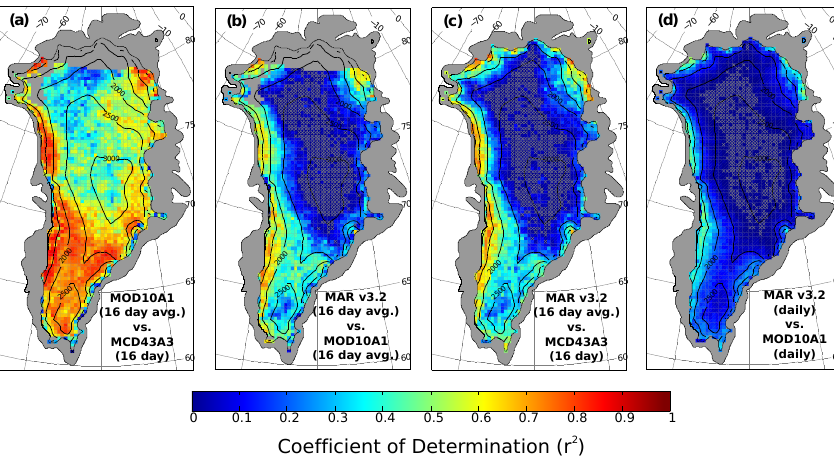
Figure 8. Coefficients of determination ( r 2 values) for the 2000–2013 period during JJA for (a) MOD10A1 (averaged to 16-day periods) vs. MCD43A3 BSA SW (b) MAR v3.2 clear-sky (16-day data) vs. MCD43A3 BSA SW, (c) MAR v3.2 clear-sky (16-day data) vs. MOD10A1 (16-day data), and (d) MAR v3.2 clear-sky (daily) vs. MOD10A1 (daily). MAR grid boxes where the correlation is not statistically significant are marked with a grey